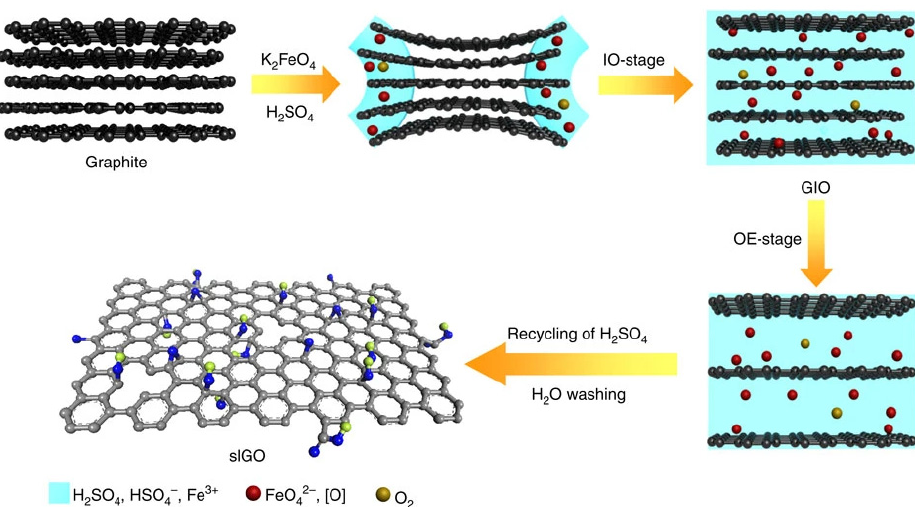
Figure 2. There are two key steps in this preparation process: intercalation-oxidation (IO) and oxidation-exfoliation (OE). In the IO step, concentrated sulfuric acid and oxidant are intercalated into the graphite layer to form intercalated graphite oxide (GIO). During the intercalation process, the oxidizer breaks the π‐π conjugate structure of graphite, creating negatively charged functional groups and increasing the interlayer spacing. In the next OE stage, the oxidizing agent further oxidizes the carbon basal plane of GIO, producing more functional groups and expanding the inter ‐ layer space. After recovery of sulfuric acid and cleaning with water, 100% slGO was attained (Blue and green balls are O and H, respectively). Reprinted with permission from Ref. [55]. Copyright 2022 Springer Nature Limited.